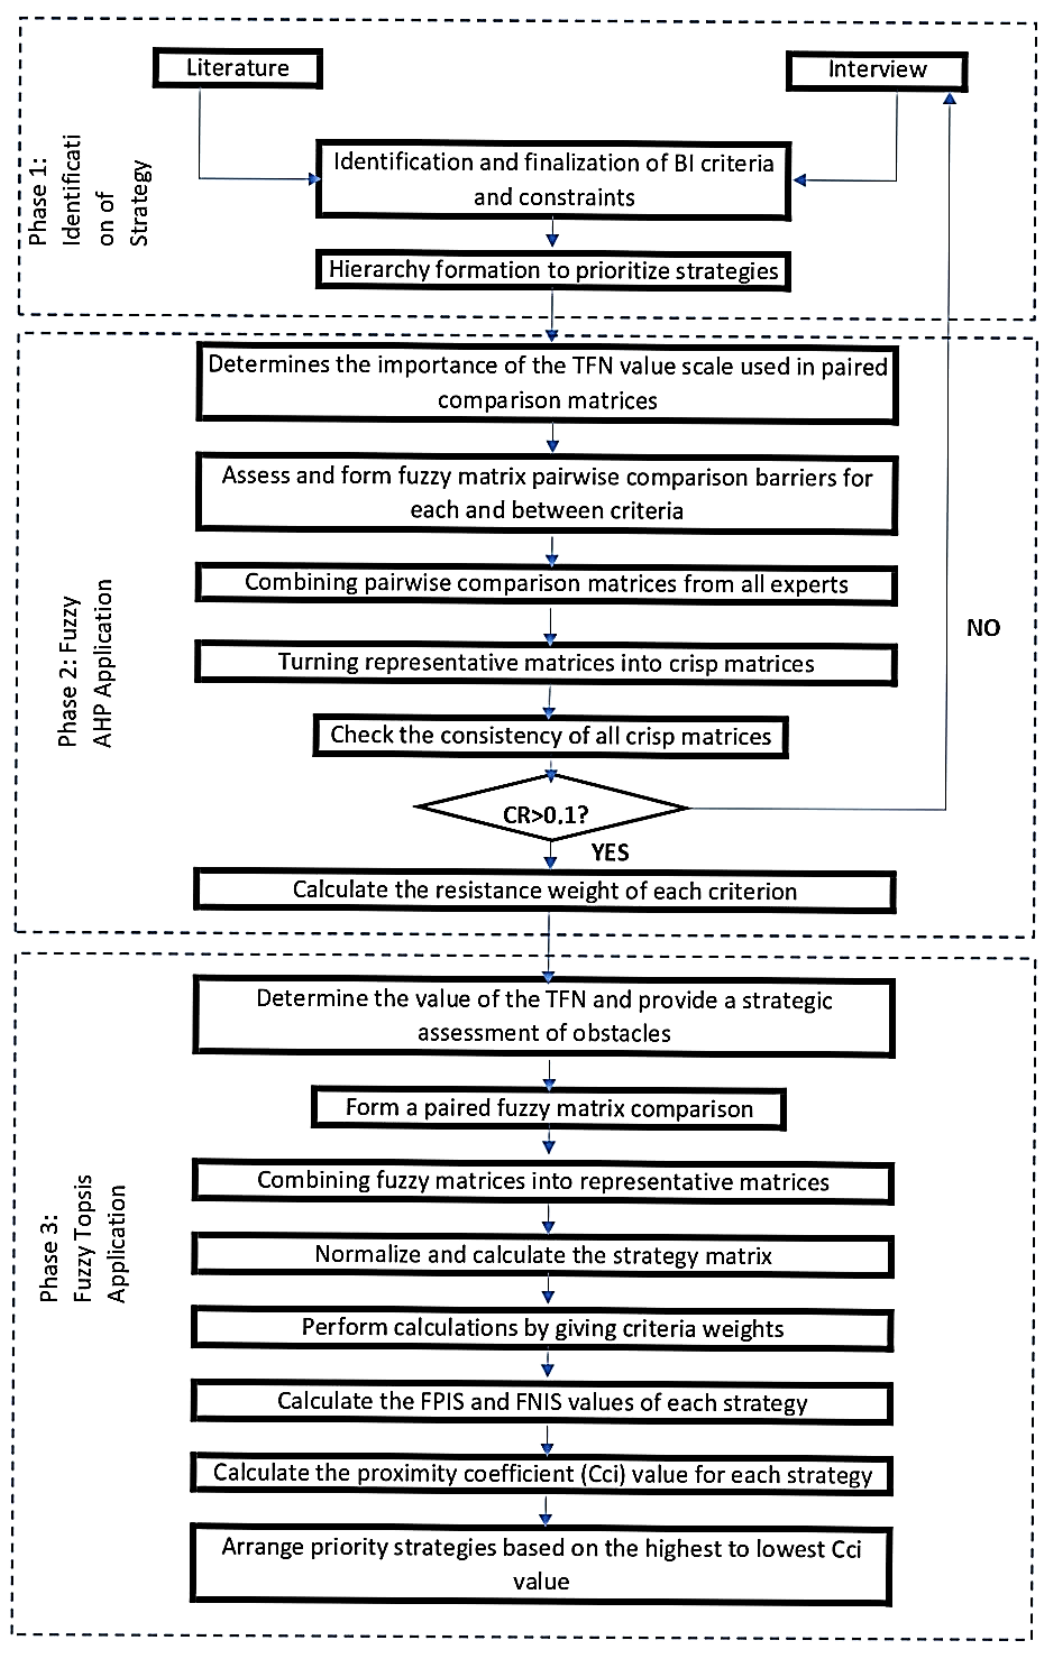
Figure 1. Flowchart of the research